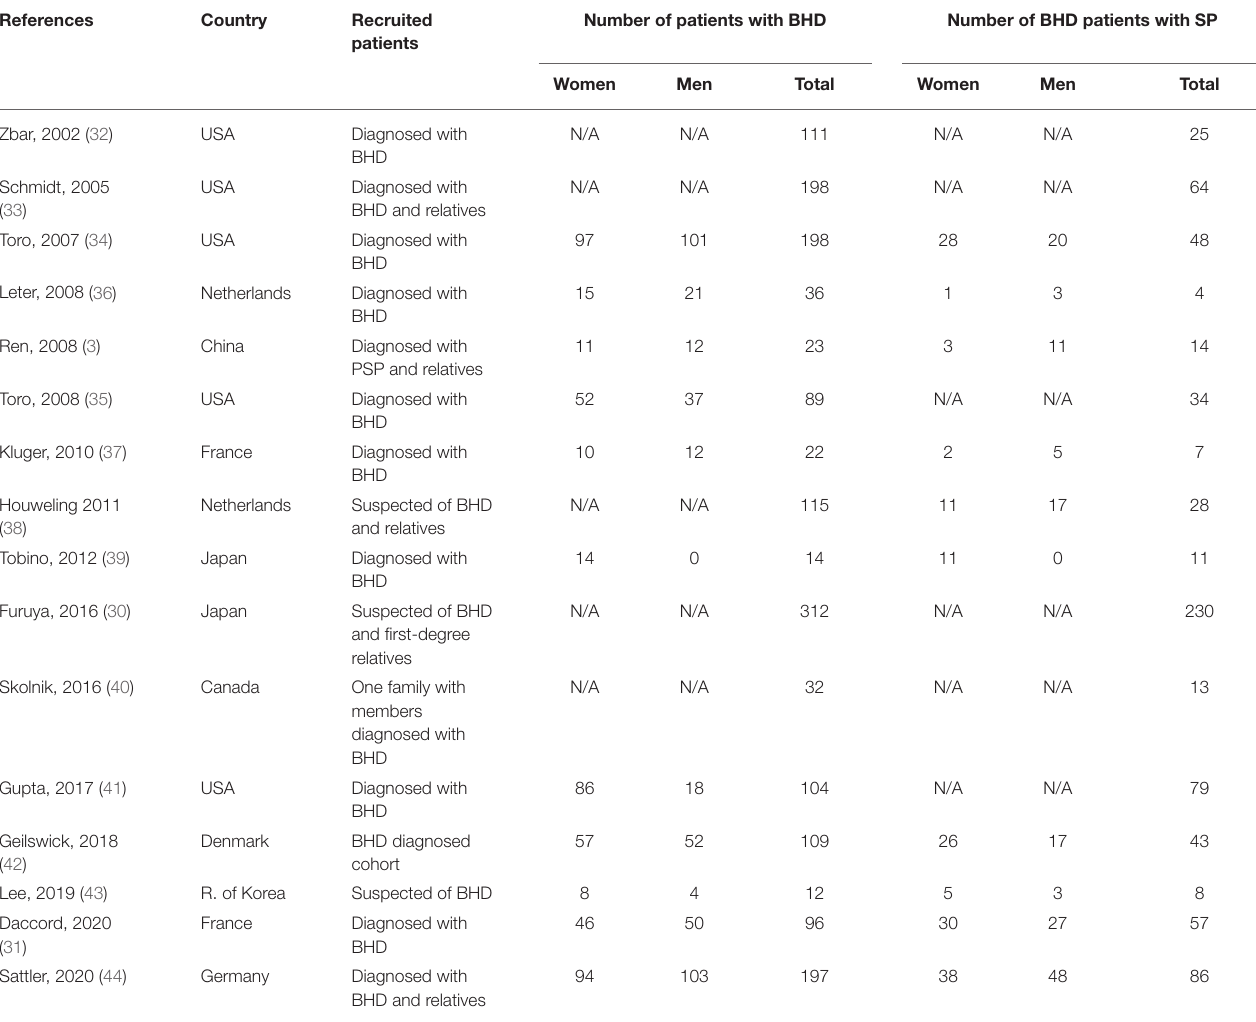
TABLE 4 | Studies reporting the proportion of patients with BHD who experienced at least one episode of spontaneous